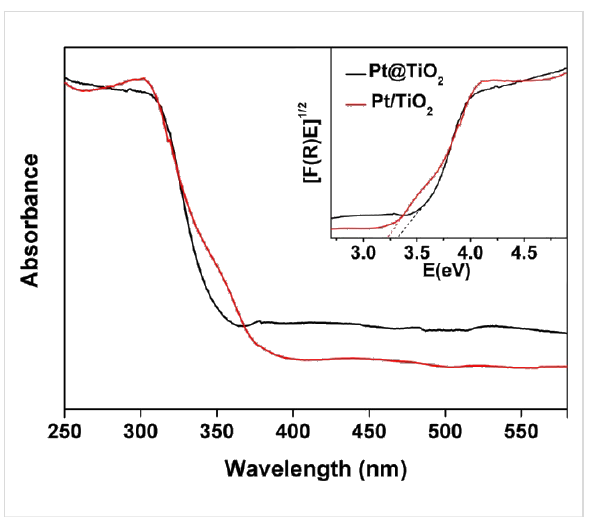
Figure 3: UV–vis diffuse reflectance spectra of the Pt@TiO 2 and Pt/TiO 2 samples.